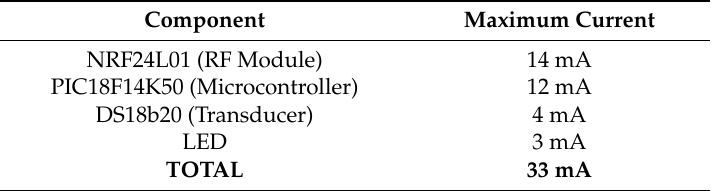
Table 1. Maximum expected current for the PCB of acquisition and communication of data.